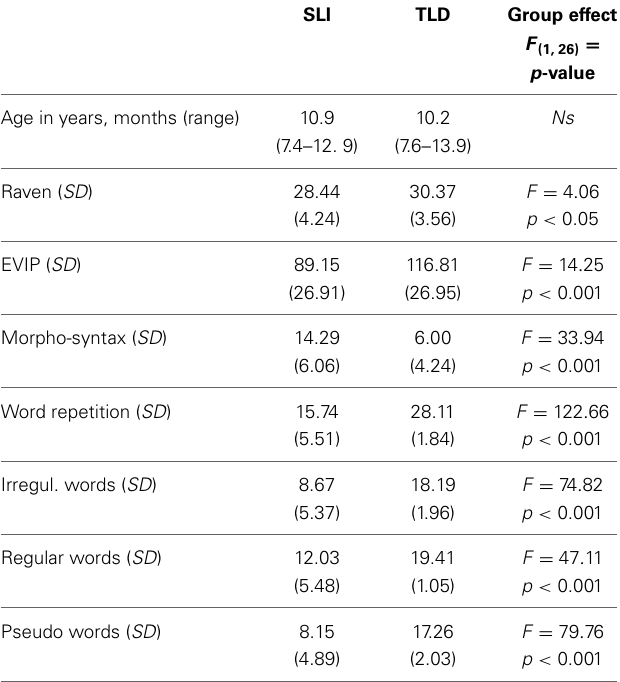
Table 5 | Characteristics of children with SLI and TLD controls in Experiment